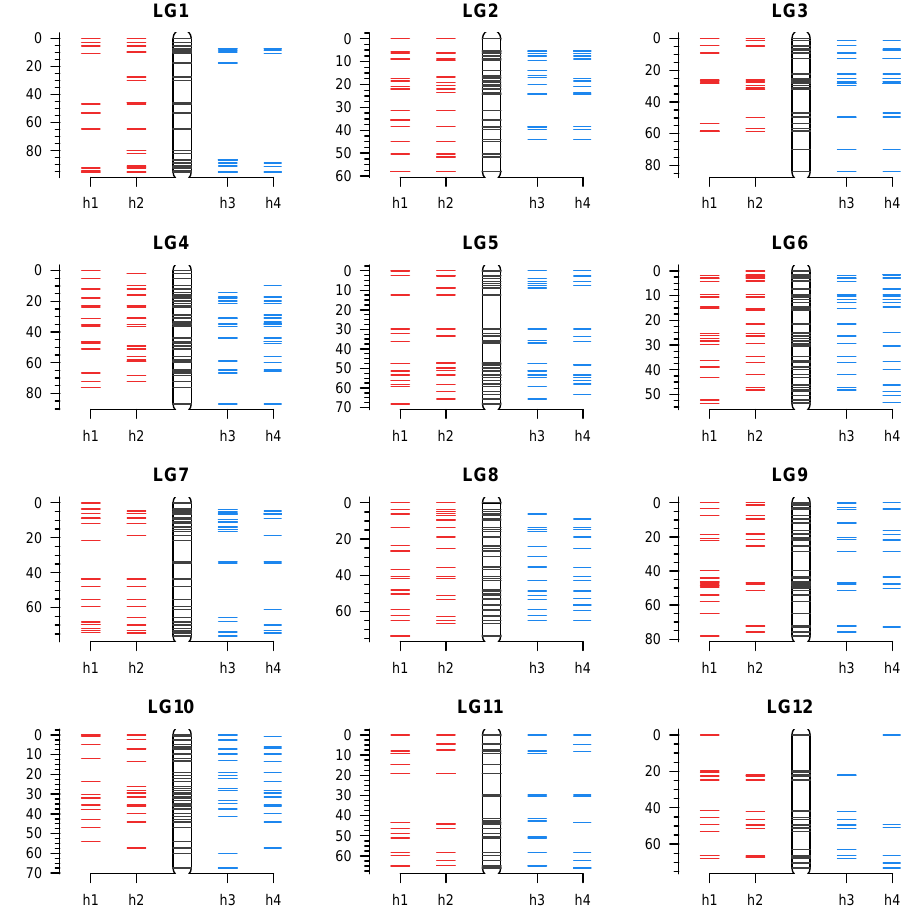
Figure 8. Phased homologue-specific map of population FRW19-112. Homologue maps from the diploid parent RH89-039-16 are shown in red (h1–h2), blue for IVP10-281-1 the diploid parent (h3–h4), and the integrated chromosomal map is shown in